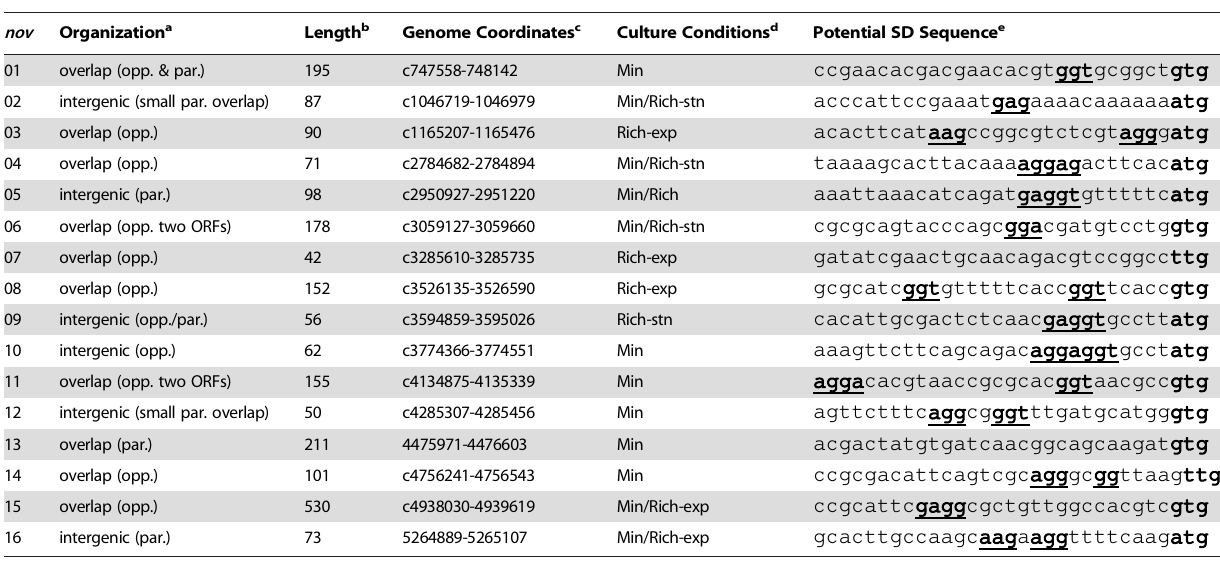
Table 1. General features of nov genes in P. fluorescens Pf0-1.